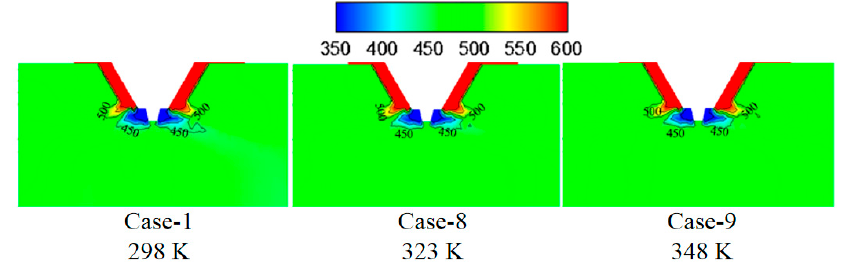
Figure 13. Turbulence kinetic energy under different wastewater initial temperatures (m 2 /s 2 ).